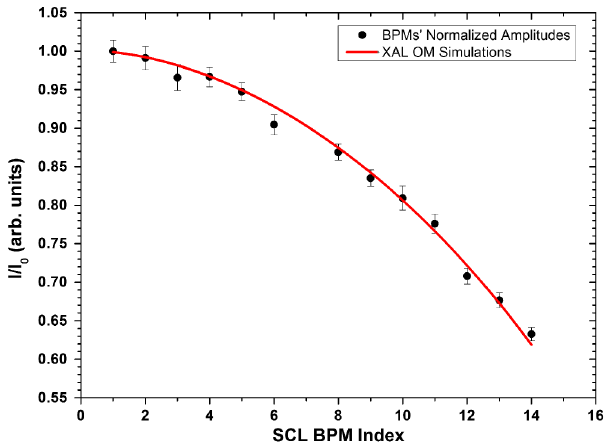
FIG. 2. Normalized BPM amplitudes in the SCL with all rf cavities switched off.